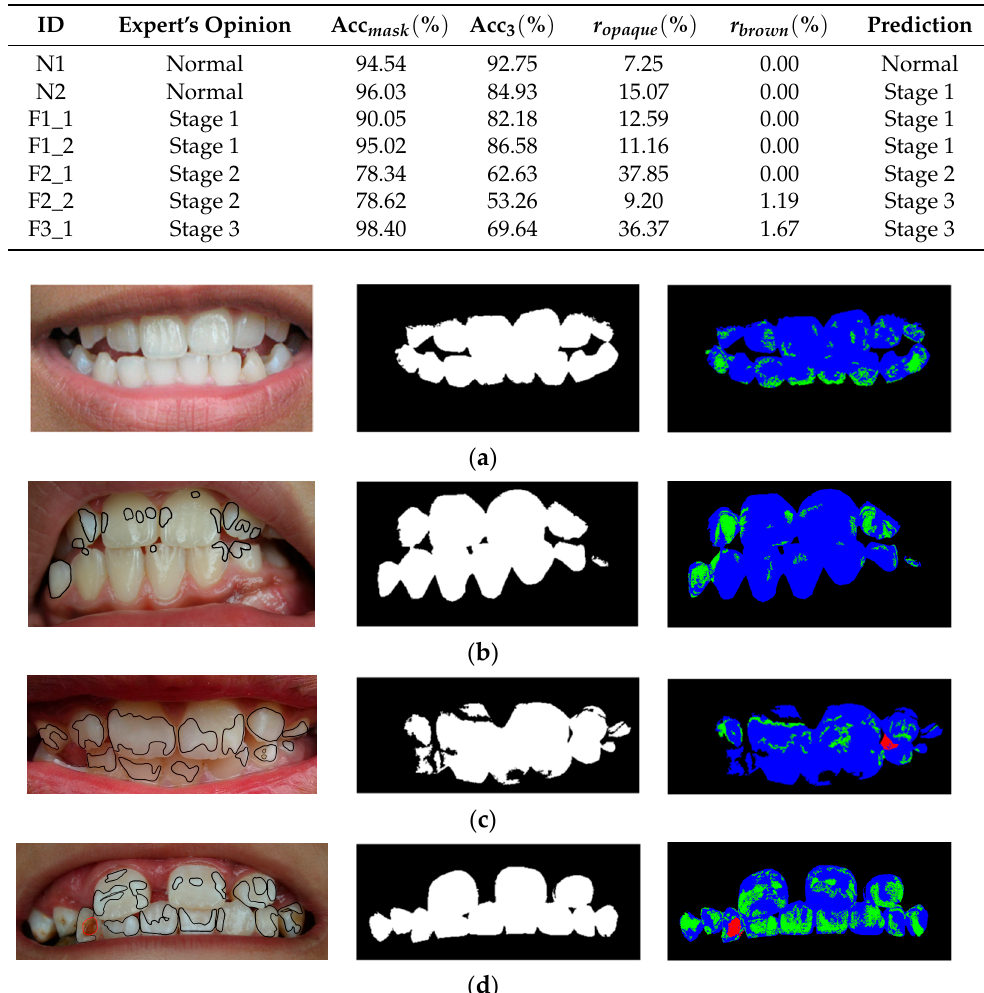
Figure 1. Examples of each fluorosis class from the training set and their segmented images: ( a ) Image N2 (Normal); ( b ) Image F1_2 (Stage 1); ( c ) Image F2_2 (Stage 2); ( d ) Image F3_1 (Stage 3). The left column presents the expert’s labels of opaque pixels and brown pixels, encircled in black and red, respectively. The center column presents the predicted binary tooth masks. The right column presents the predicted white–yellow, opaque, and brown pixels in blue, green, and red colors, respectively. and 22,737 opaque pixels with no brown pixels, resulting in the Acc 3 = 86.58% correct classification rate in Table